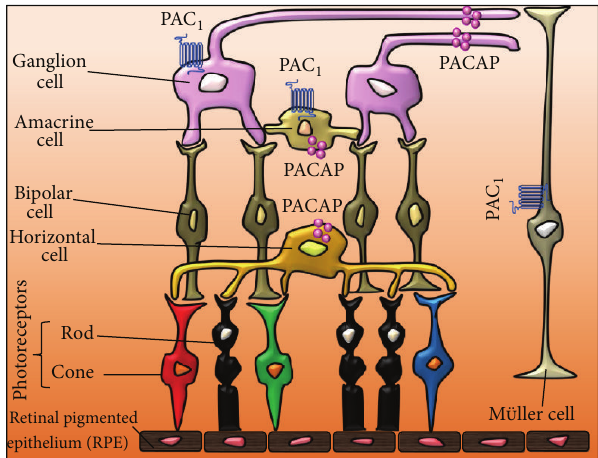
Figure 2: Representative schematic illustration showing PACAP and PAC1 distribution in rodent retina. Immunohistochemical studies have shown that PACAP immunoreactivity (IR) is detectable in nerve fibers (neurites) originating from retinal ganglionic cells as well as in neuronal cell bodies of amacrine and horizontal cells in the inner nuclear layer. No evidence of PACAP-IR has been provided in photoreceptors in the outer nuclear layer (ONL) or in the retinal pigmented epithelium (RPE) [22, 28,